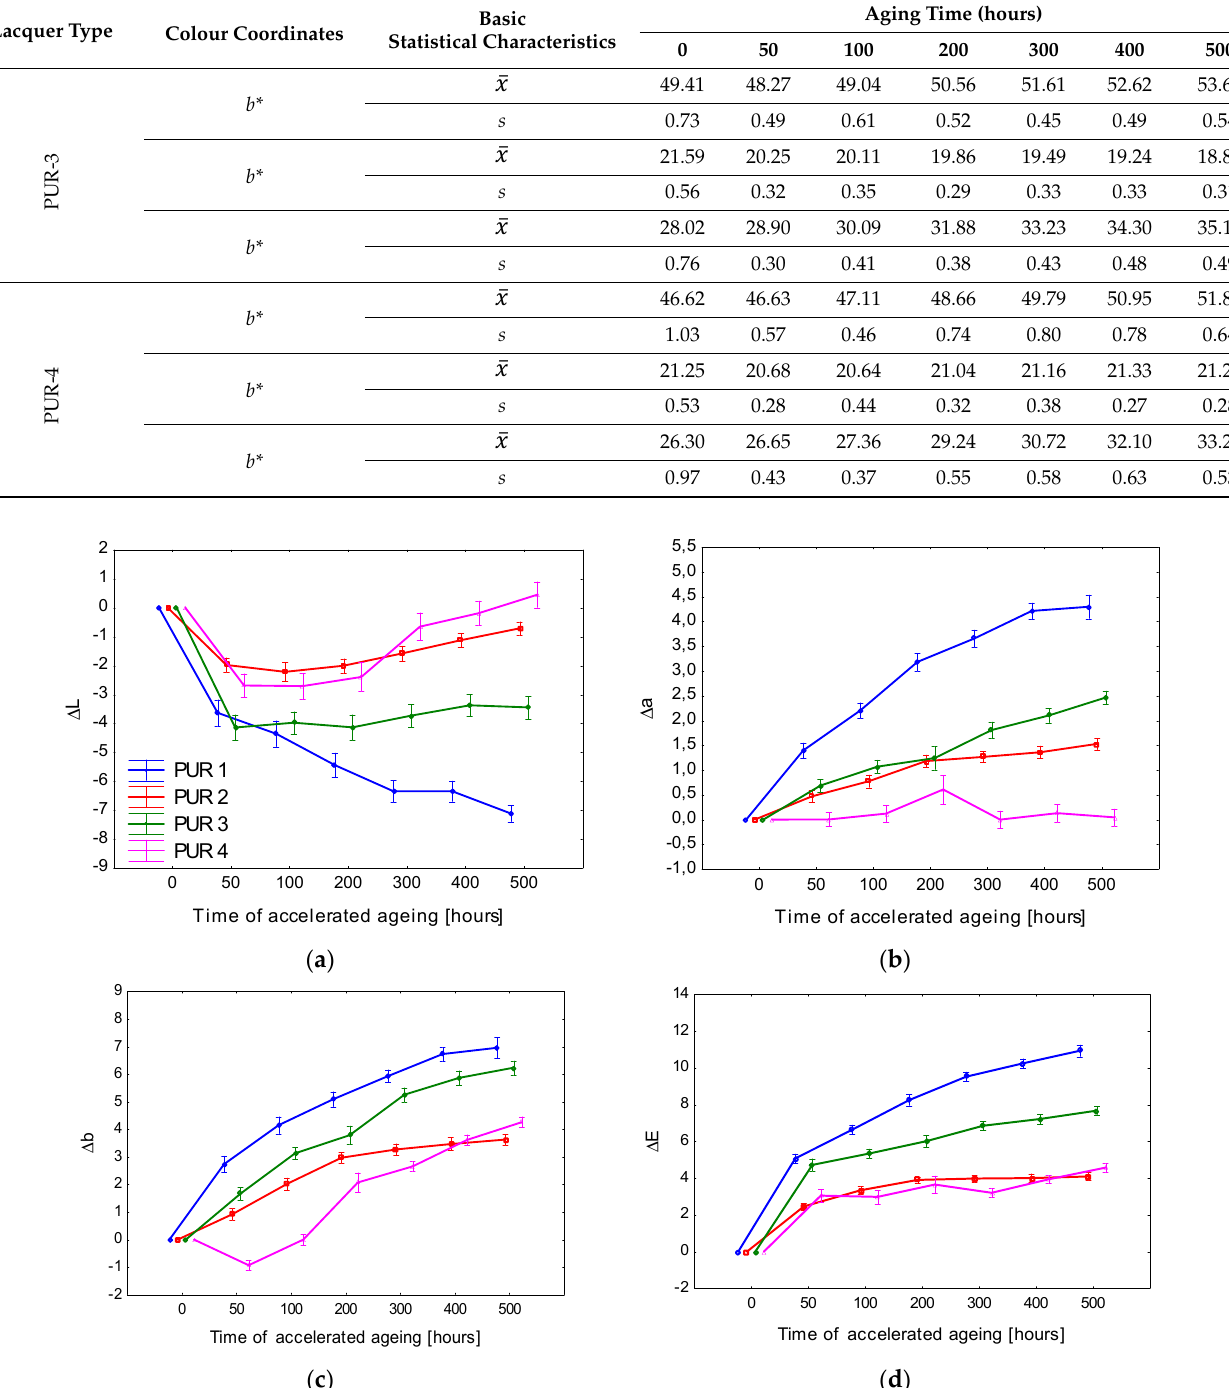
Table 3. Basic statistical characteristics of colour coordinates L * , a * , and b * corresponding to different phases of the accelerated aging process of spruce wood surface-treated with polyurethane lacquers. (The number of measurements for each set n = 50.)